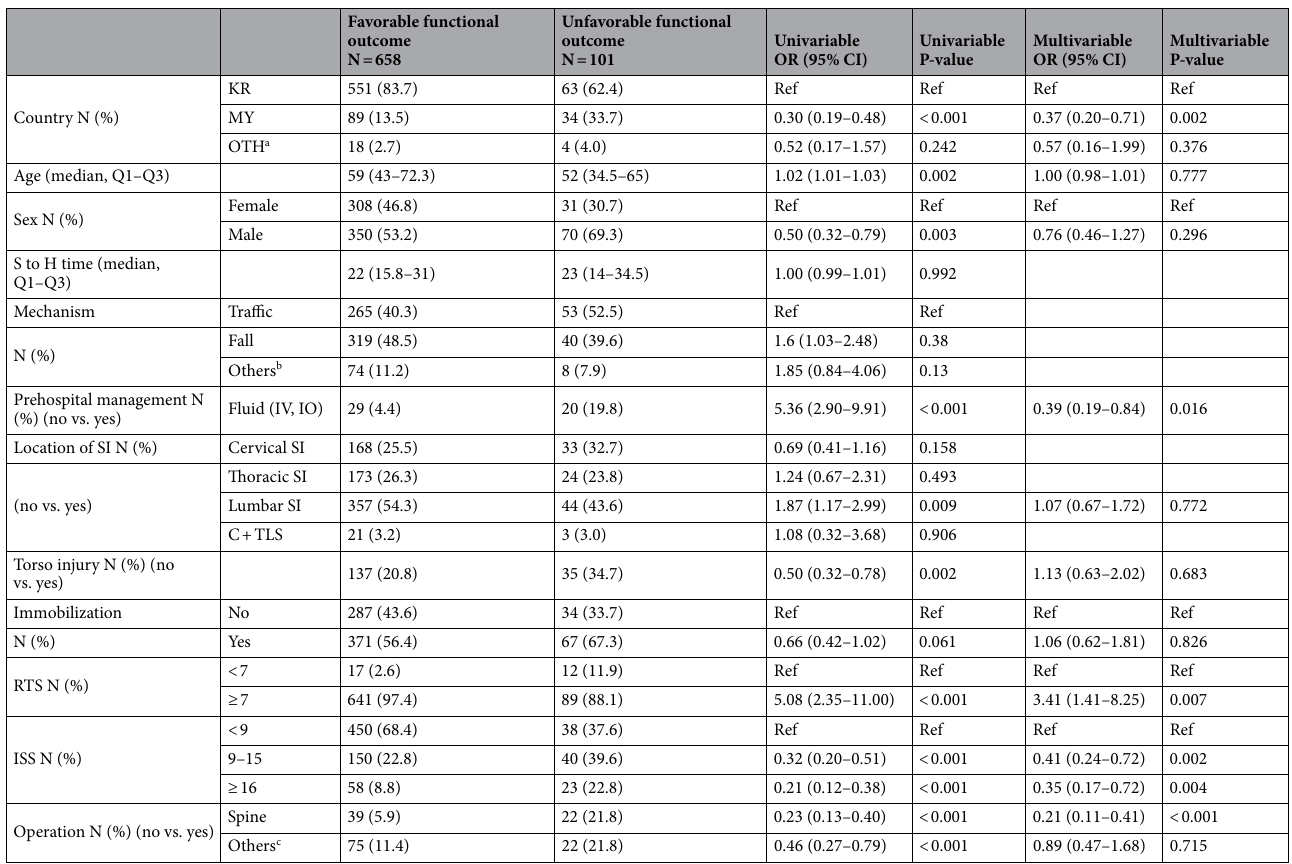
Table 2. Demographic, univariable, and multivariable-adjusted logistic regression of favorable and unfavorable functional outcomes in patients. KR Korea, MY Malaysia, OTH others, S to H time scene to hospital time, SI spinal injury, RTS revised trauma score, ISS Injury Severity Score. a Others: Japan and Vietnam. b Others: hit by person or objects, choking or hanging, drowning, physical overexertion, another mechanism of injury. c Other operations: One patient could have undergone several operations during the same hospital